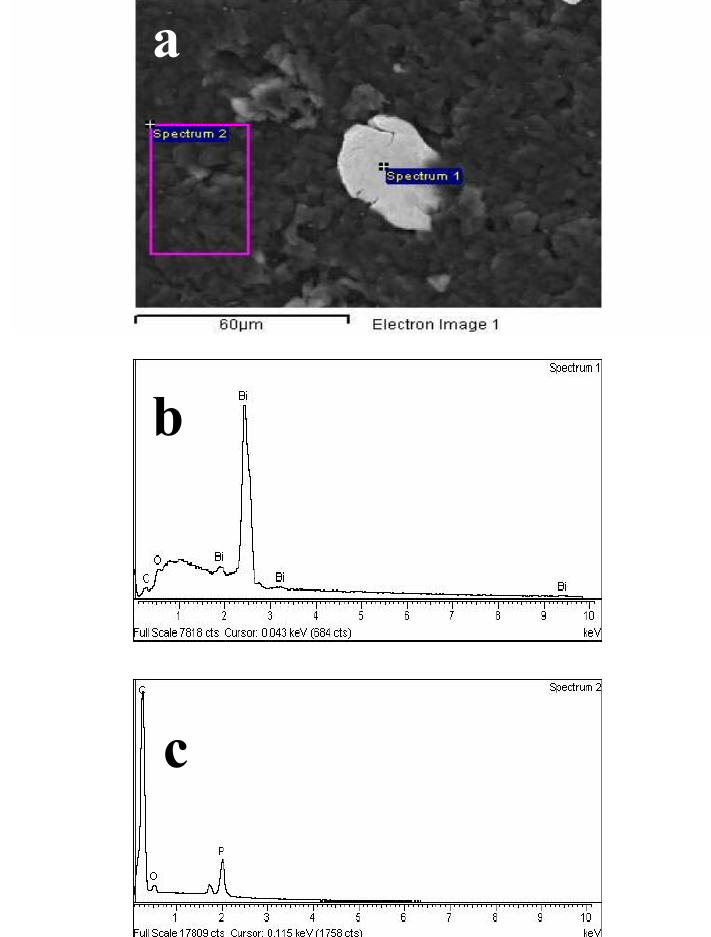
Figure 7. Representative part of the Bi5-TCP-CPE surface ( a ). EDS microanalysis spectra of the bismuth island surface area ( b ) and of the carbon paste matrix ( c